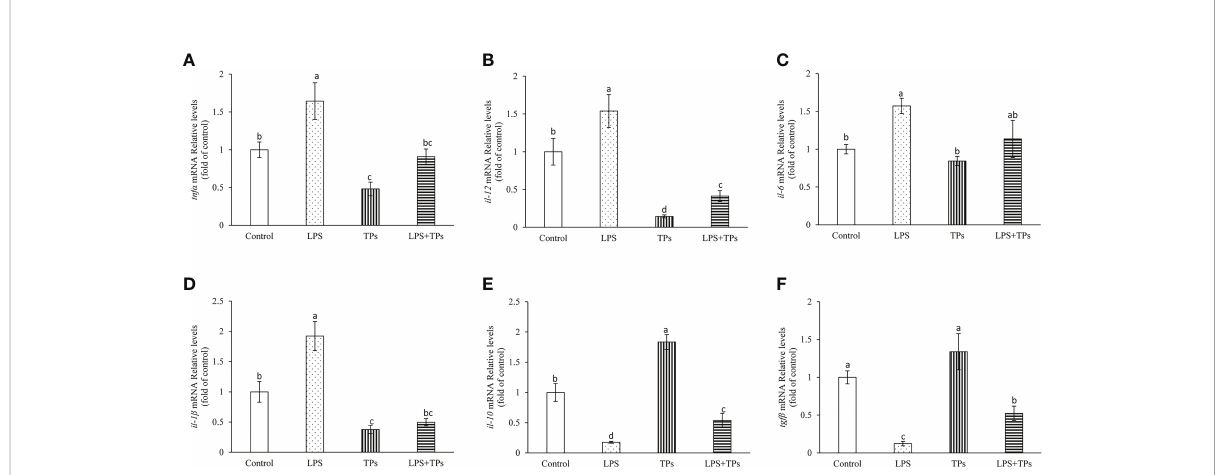
FIGURE 5 Effects of LPS and tea polysaccharides on genes expression related to immunity in common carp spleen cells. (A) tnf a ; (B) il-12 ; (C) il-6 ; (D) il-1 b ; (E) il-10 ; (F) tgf b . The cells were seeded in 24-well plates at 1×10 6 per well in 1mL DMEM/F12 with 10% FBS. The next day, cells were placed in DMEM/ F12 without FBS for 1 h. Then, the cells were treated with LPS (25 m g/mL), tea polysaccharides (400 m g/mL), LPS (25 m g/mL) + tea polysaccharides (400 m g/mL) for 12 h. All data are shown as mean ± S.E.M. (n = 5-6). Signi fi cant differences ( P <0.05) were indicated by different